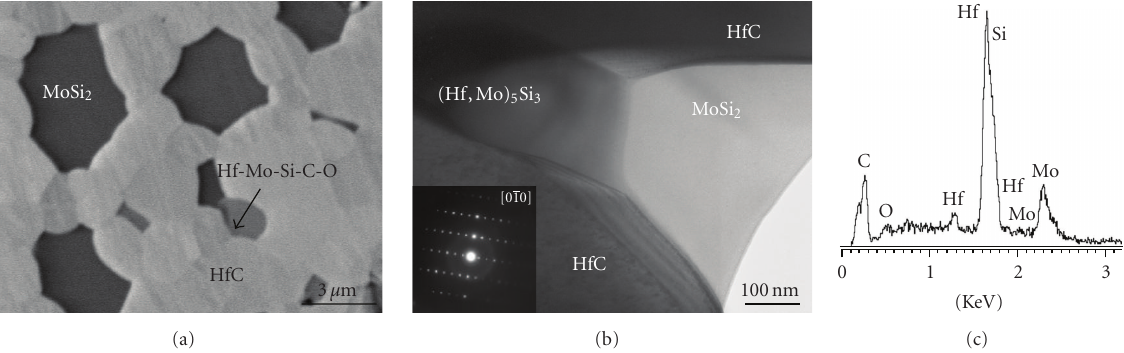
Figure 6: (a) SEM micrographs of the polished surface of HC20. The bright grains are HfC, the dark phase is MoSi 2 , the arrow indicates the reaction product formed during sintering containing Hf-Mo-Si-C. (b) BF-TEM image evidencing the reaction product, identified as (Hf,Mo) 5 Si 3 and the corresponding electron di ff raction pattern and (c) the EDS